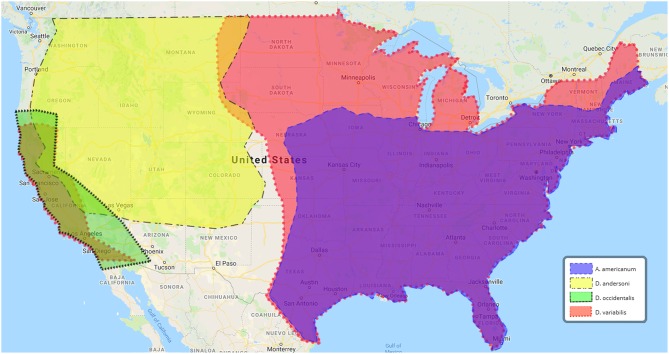
U.S. geographic distribution of ticks associated with human tularemia. Data adapted from the Centers for Disease Control and Prevention, https://www.cdc.gov/ticks/geographic__distribution.html.